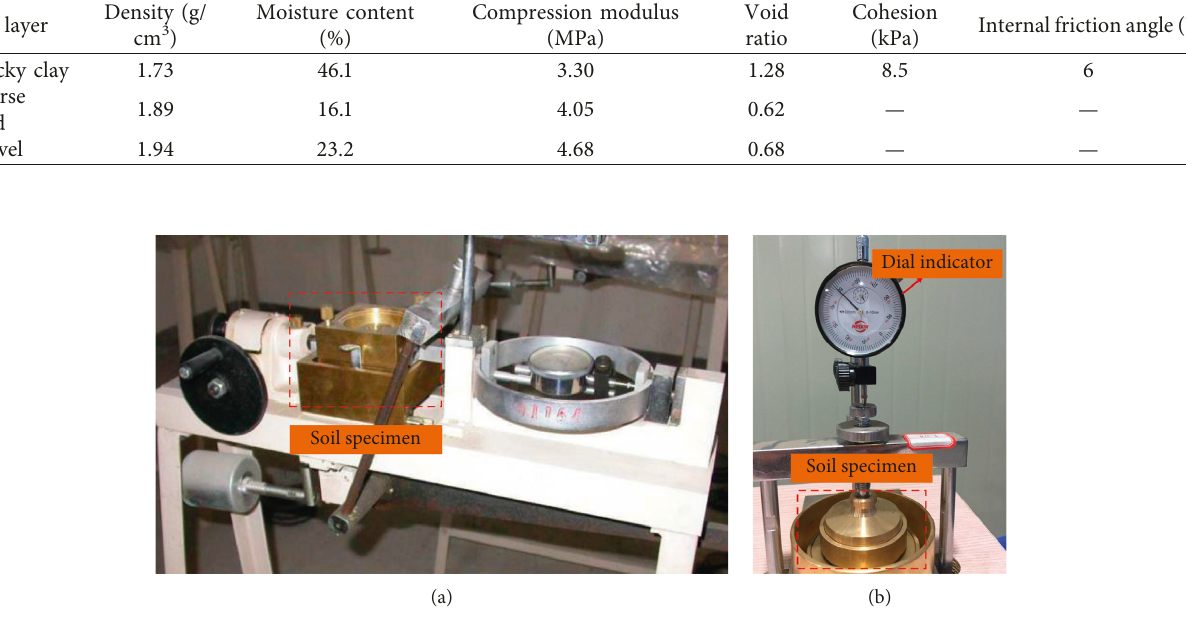
Figure 7: Tests: (a) direct shear test and (b) oedometer test.